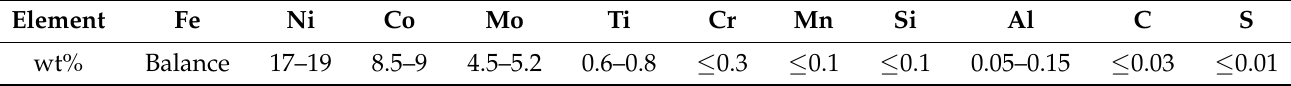
Table 3. Chemical composition of Maraging-steel